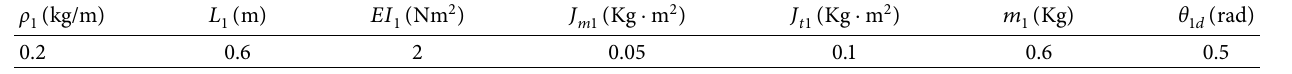
Table 1: The parameters used to compare with pure boundary control method. Parameters of link 1.